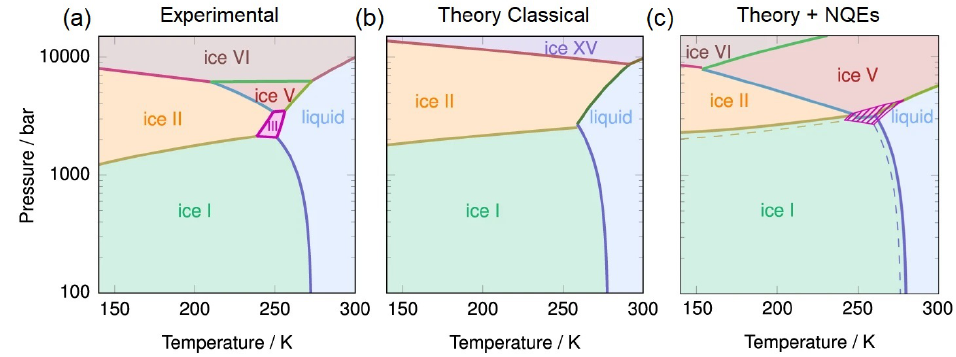
Figure 16. Experimental ( a ) and computational ( b – c ) phase diagrams of H 2 O in the range T = 50–300 K and p = 0.02–1 GPa. The computational phase diagrams have been obtained with classi- cal ( b ) and PIMD simulations ( c ) using a vdW-corrected hybrid-DFT (revPBE0-D3). See Ref. [407] for more details. Adapted with permission from Ref.